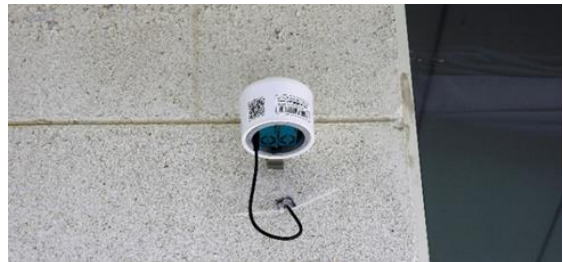
Figure 2. Example of a sensor installation at the University of